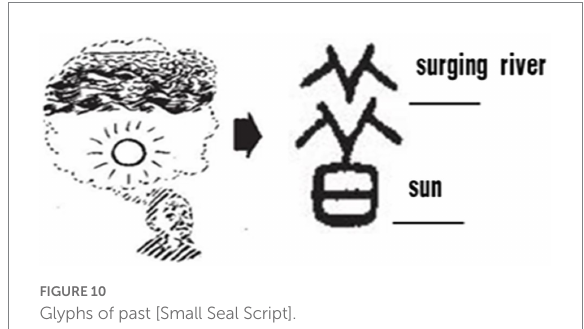
FIGURE 10 Glyphs of past [Small Seal Script].